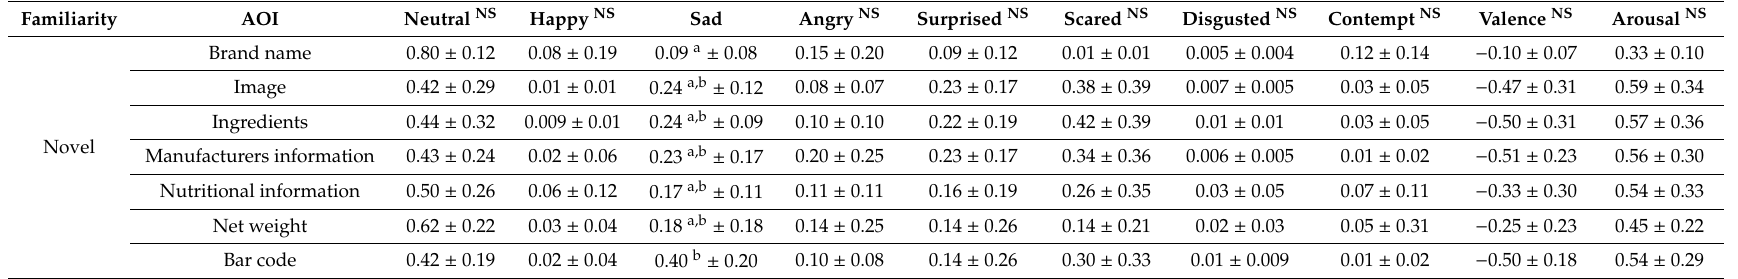
Table 4. Mean values (top) and standard deviation (bottom) of FaceReader ™ outputs during the fixation on a defined AOI in novel packaging concepts.